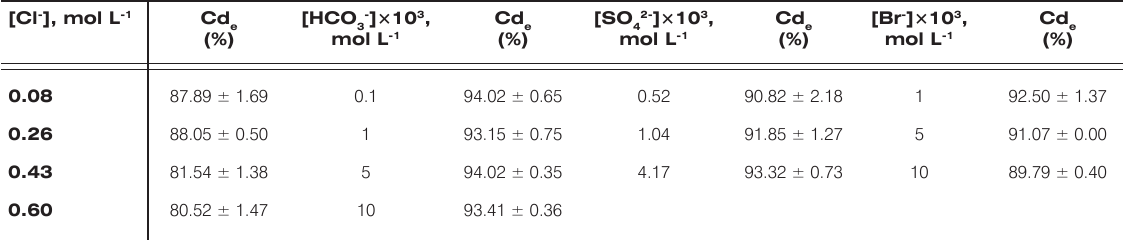
Table 1. Experimental values of cadmium extracted (%) under the presence of inorganic ligands.